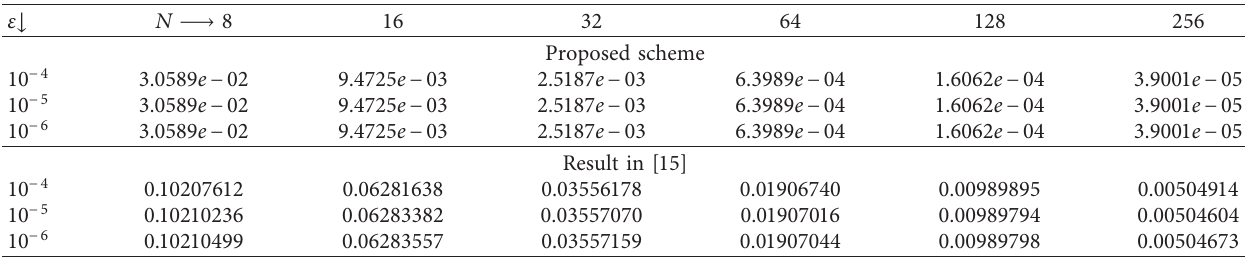
Table 9: Example 3: comparison of maximum absolute error of proposed scheme and result in [15] for δ � 0 . 6 ε and η � 0 . 5 ε .